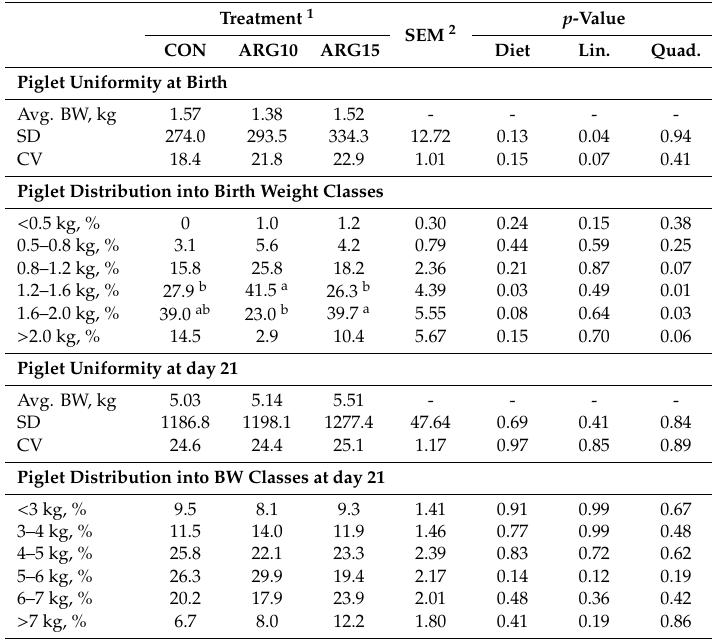
1 CON: corn-SBM-based diet with Arg 0.72%, Arg10: corn-SBM-based diet with Arg 1.0%, Arg15: corn-SBM-based diet with Arg1.5%. 2 Standard error of the mean. a,b Means in the same row with different superscript letters were significantly different ( p < 0.05). Lin.: linear, Quad.: quadratic, Avg. BW: average body weight, SD: standard deviation, CV: coefficient of variation.